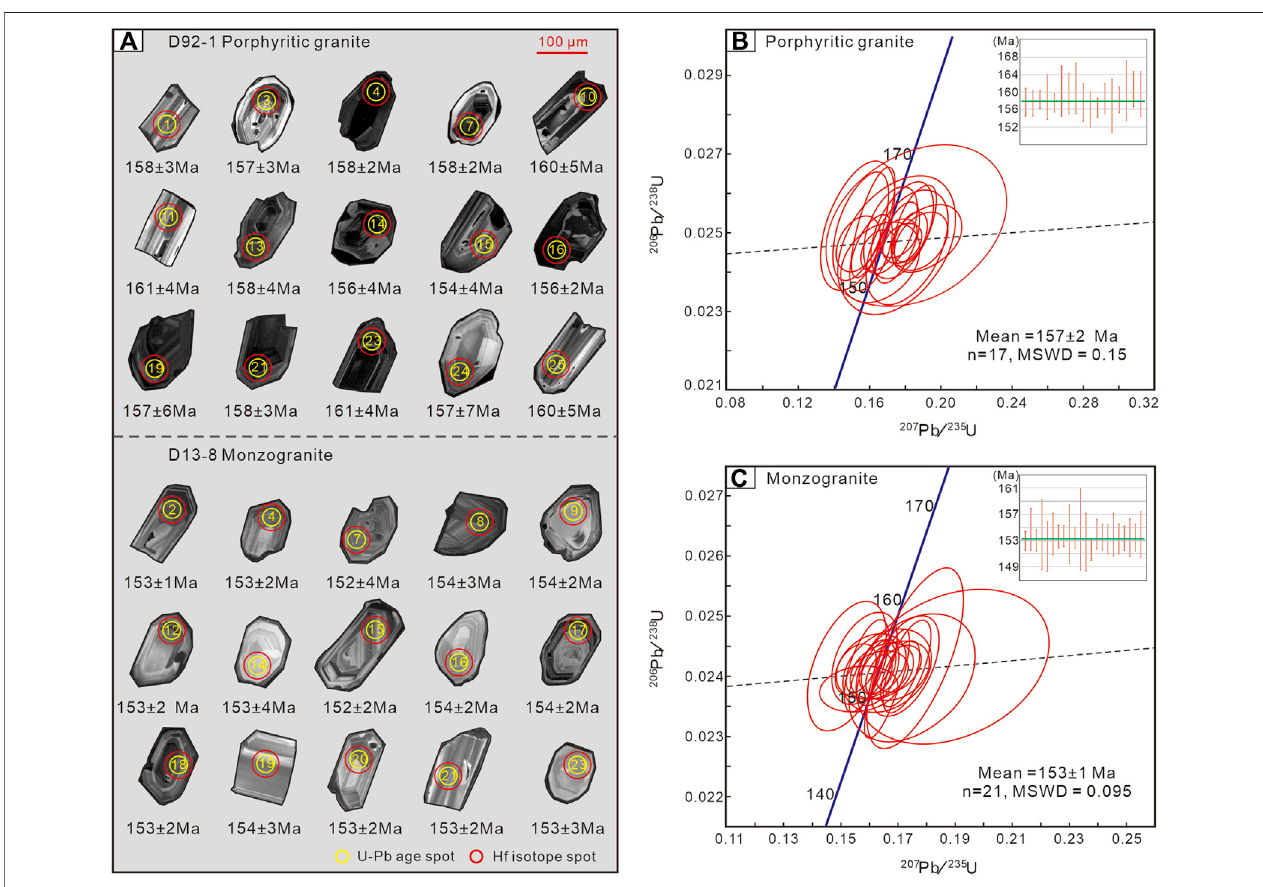
FIGURE 3 | Zircon CL images (A) and U-Pb dates (B , C) for Yaozhuang stock.